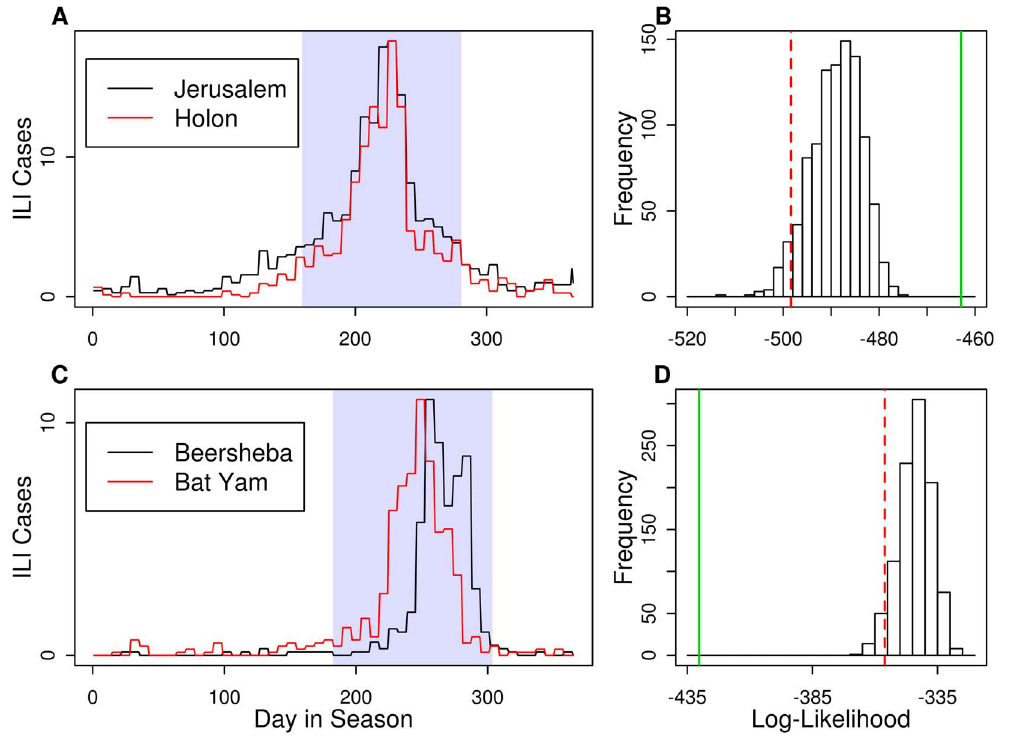
Figure 4. Comparison of Incidence Curves: two examples. Top (A,B): Jerusalem and Holon in the 1999–2000 season. Incidence time series curves (A) are very similar. A period of 120 days containing the largest number of ILI cases (highlighted with a darker band) was used to calculate the likelihood of the observed incidence curves. Histogram of log-likelihoods (B) of 1,000 simulated epidemics (equations 20–22) gives a one-sided 95% confidence limit (dashed red line) and the log-likelihood of the real data (solid green line) is very high compared to those of simulated epidemics, indicating that simulated epidemics are less similar than the observed data. Bottom (C,D): Beersheba and Bat Yam in the 2008–2009 season. Dramatic differences in the shape of the incidence curves (C) translate to a very low log-likelihood of the observed epidemic compared to those of simulated ones (D).